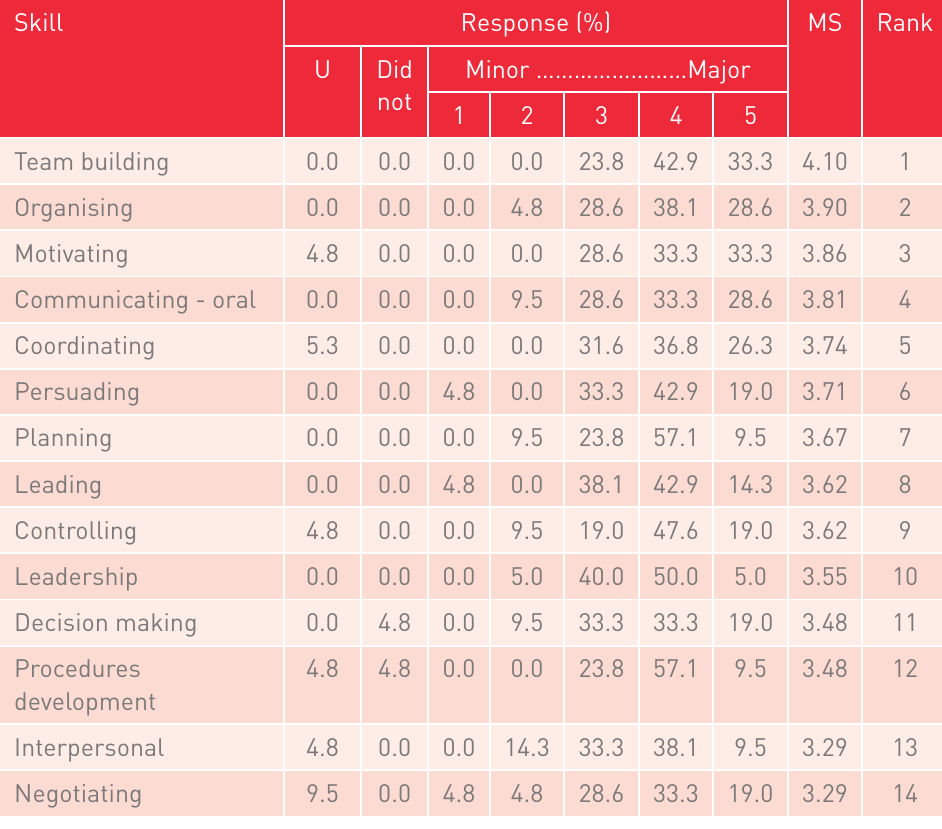
Extent to which the team building activities enhanced participants’